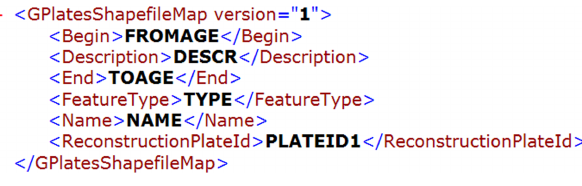
Fig. 31. The XML file keeping the mapping configuration.